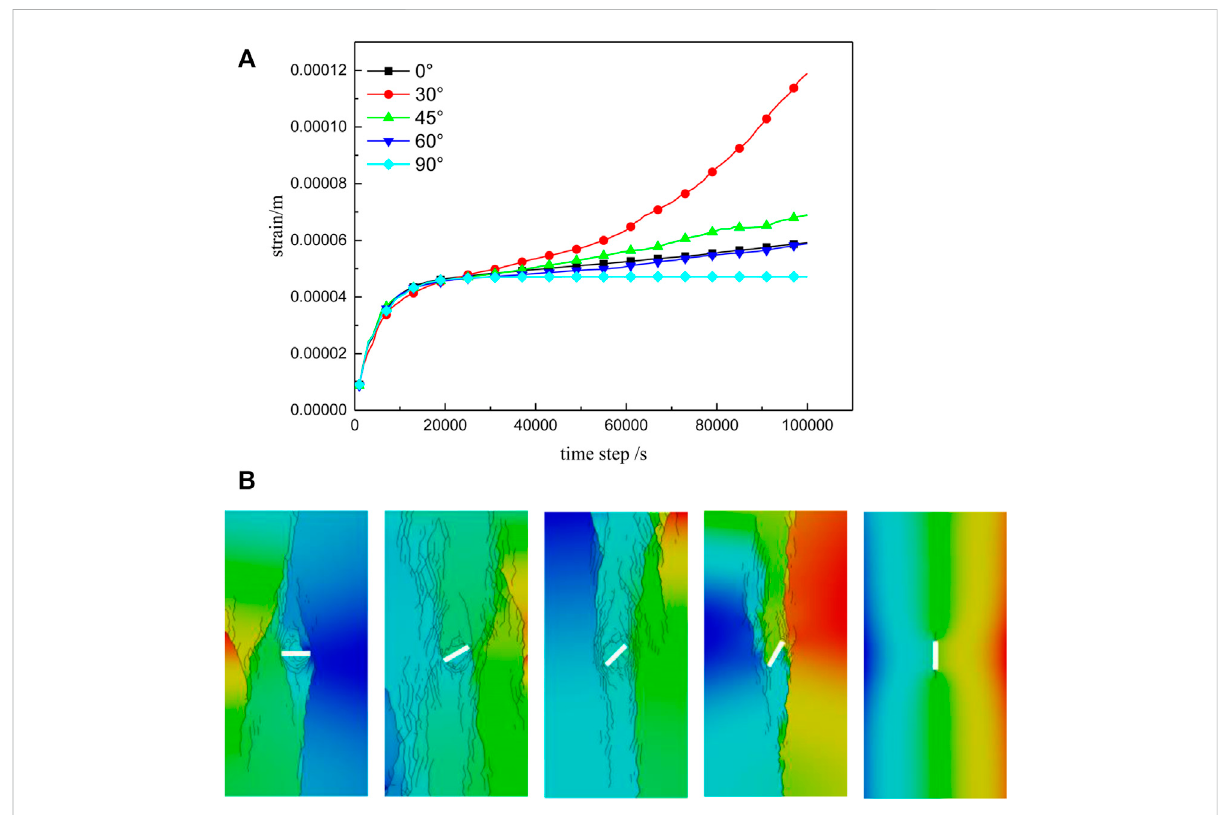
FIGURE 7 Creep curves (A) and fracture diagrams (B) for single-fracture rock masses with different fracture angles.